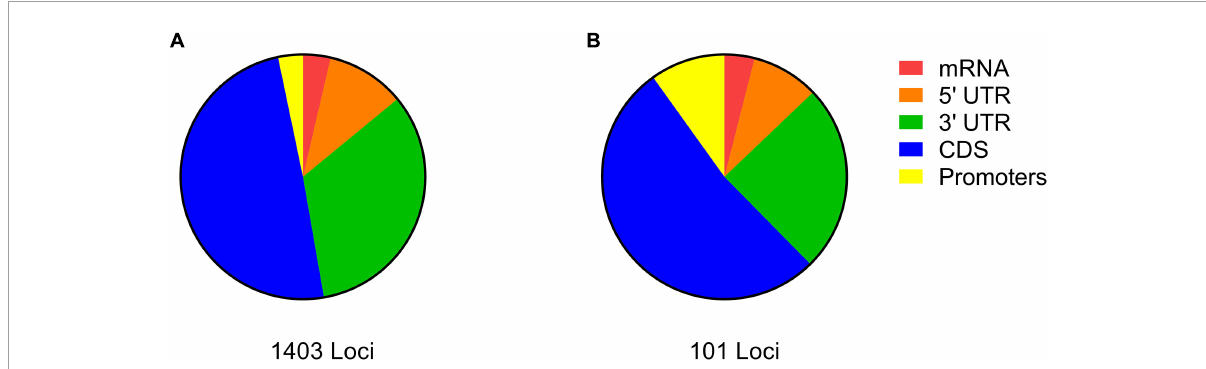
FIGURE1 The categorization of differentiated loci detected by the AF-F ST (A) and environmental parameters (B) to different genic